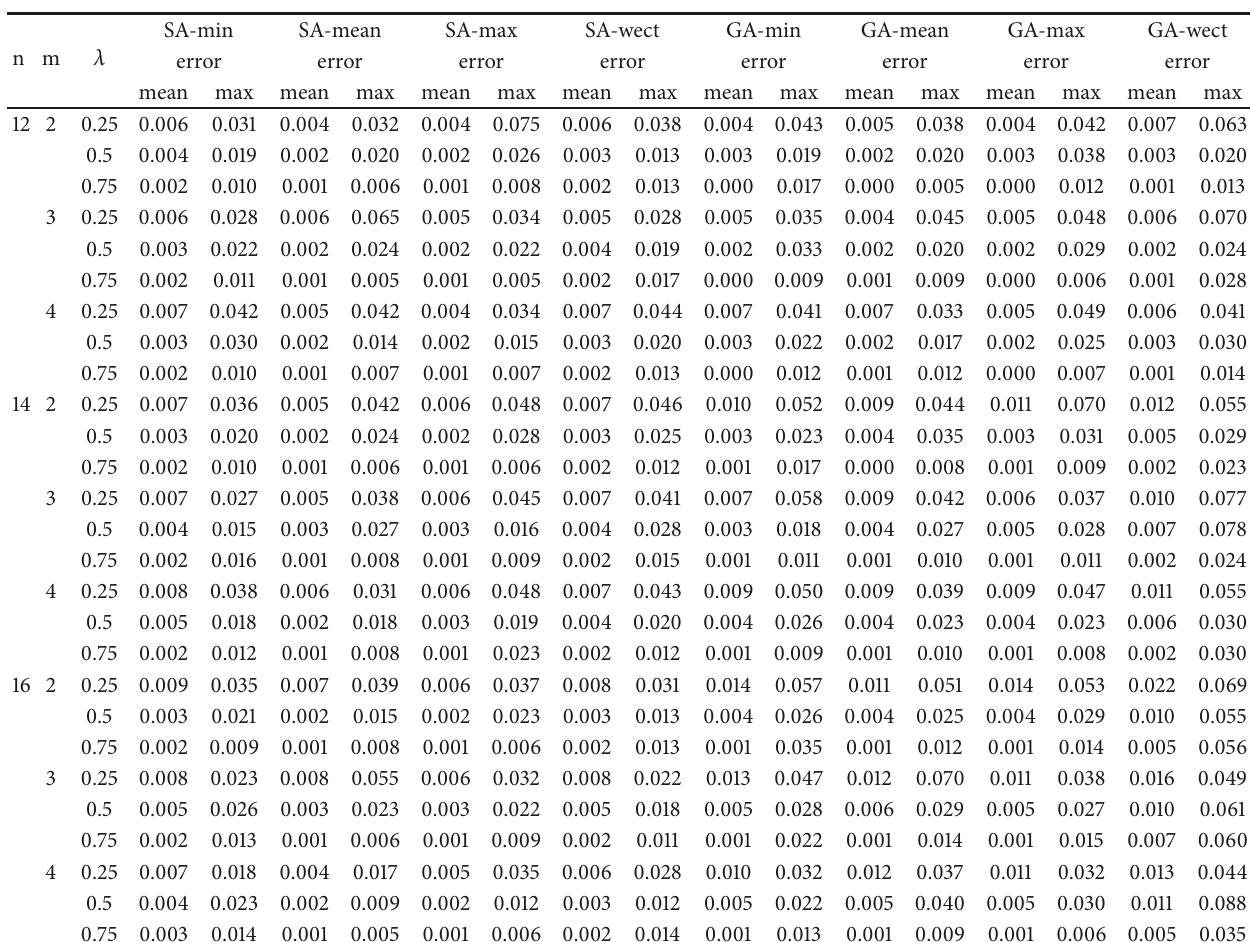
Table 5: Computational results of the SAs and GAs for small number of